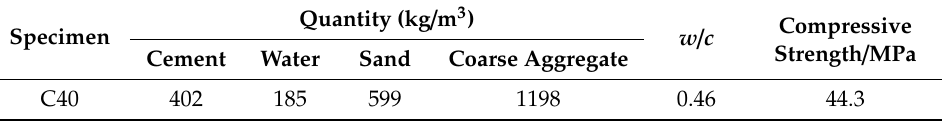
Table 1. Mix proportions of the concrete.